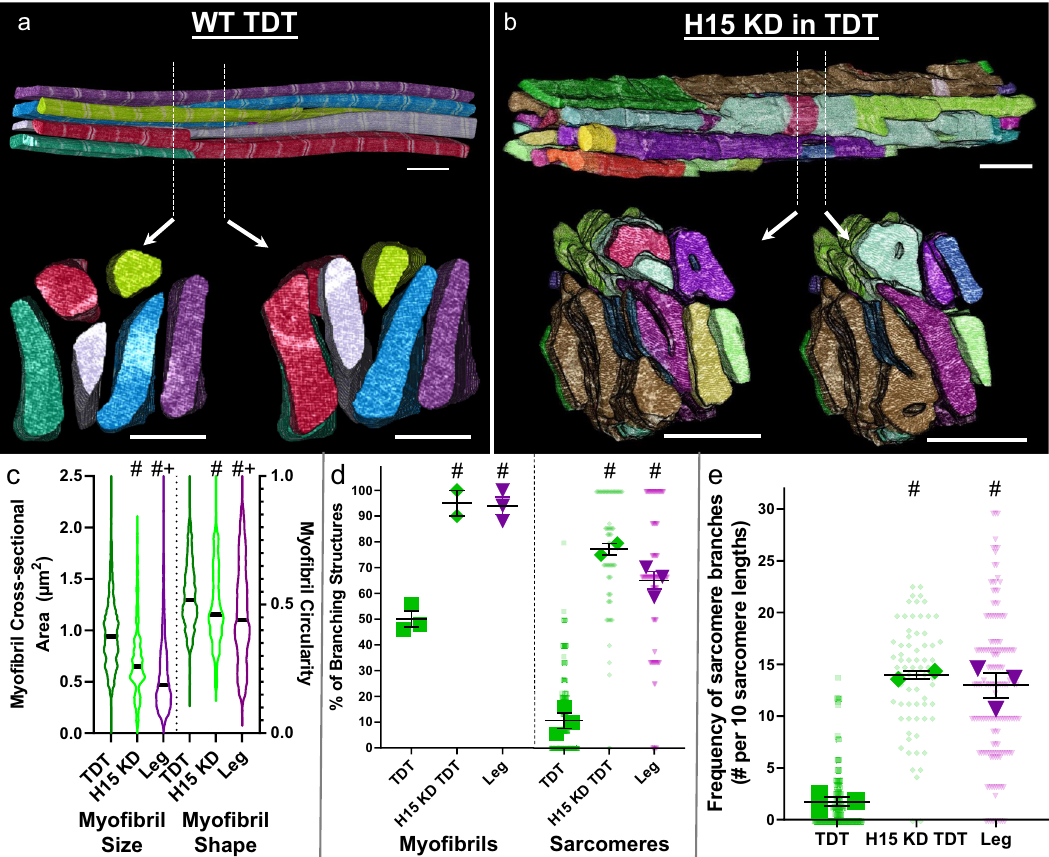
Fig. 2 Loss of H15 increases TDT muscle sarcomere branching to leg muscle levels. a , b 3D rendering of myo fi brillar matrix in TDT muscles with ( b ) and without ( a ) Mef2-Gal4 driven RNAi knockdown of H15 . Bottom two images show clippings through the long axis of the muscle directly above. c Assessment of myo fi bril size and shape for TDT, H15 KD TDT, and leg muscles. d Percentage of myo fi brils with at least one branching sarcomere (left) and percentage of sarcomeres per myo fi bril with a branch (right). e Frequency of sarcomere branching in TDT, H15 KD TDT, and leg muscles. N values: TDT — 3 muscle cells, 2 datasets, 160 myo fi brils, 1863 sarcomeres; H15 KD TDT — 2 muscle cells, 1 dataset, 70 myo fi brils, 403 sarcomeres; and leg — 3 muscle cells, 2 datasets, 150 myo fi brils, 690 sarcomeres. Larger shape symbols represent data from a single cell and smaller shape symbols represent data from a single myo fi bril. Bars represent muscle cell overall mean ± SE. Hash sign (#): Signi fi cantly different from tubular TDT ( P < 0.01). Plus sign ( + ): Signi fi cantly different from H15 KD TDT (one-way ANOVA, P < 0.05). Scale bars — 2 μ (Fig. 4g). Conversely, taking into account the relative volume of each myo fi bril by measuring the volume-weighted average shows that the average myo fi bril CSA is larger for NCDN KD (2.86 µm 2 ) than in the wild type (2.16 µm 2 , gray boxes, Fig. 4g). The circularity